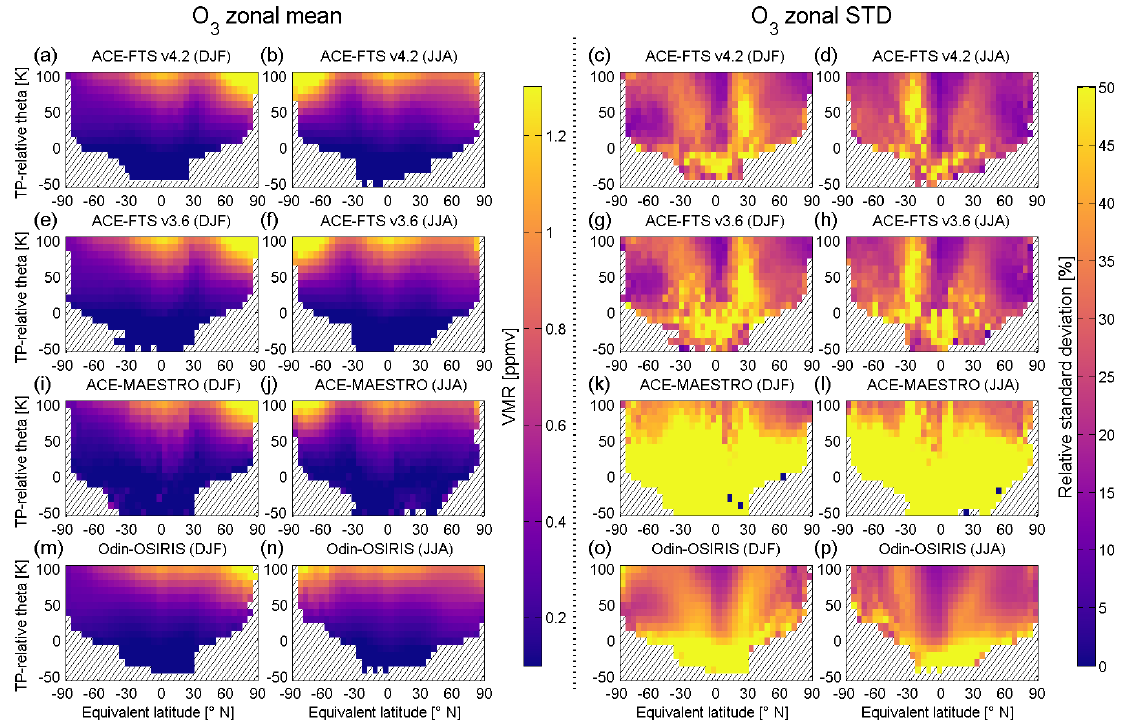
Figure 4. Same as Fig. 1 but for ozone and including an additional row (m–p) for climatologies constructed from the OSIRIS dataset. The MAESTRO relative standard deviation is shown on a logarithmic colour scale in Fig. 7 to better illustrate the large values